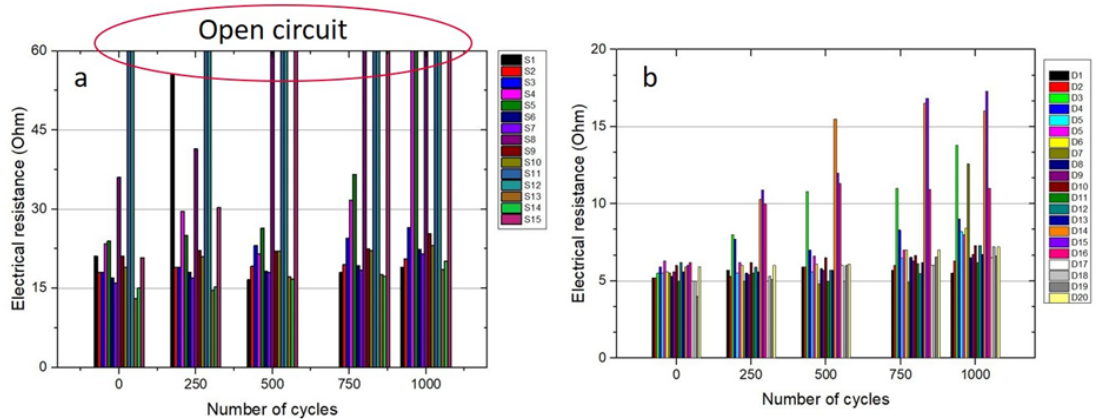
Figure 9. Temperature cycling test results of single-layered ( a ) and double-layered ( b ) Ag tracks. It was postulated that the thin layers are prone to higher reliability issues since the thin single layer cannot accommodate the thermomechanical stresses due to the CTE mismatch between EMC ( ⁓ 7 ppm/K) and sintered ink ( ⁓ 19 ppm/K) during the thermal cycle tests. There was also a risk that a